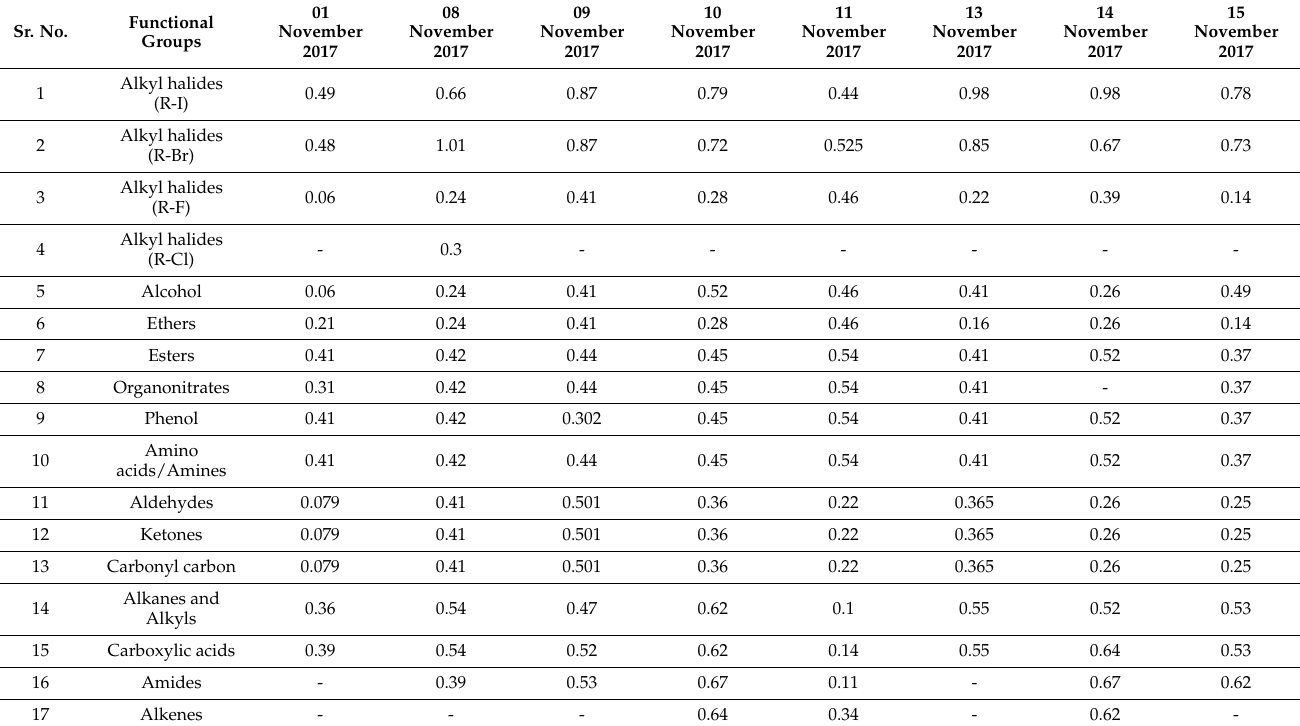
Table 4. Variations in PM 2.5 -associated organic functional groups (in absorbance units) during Smog